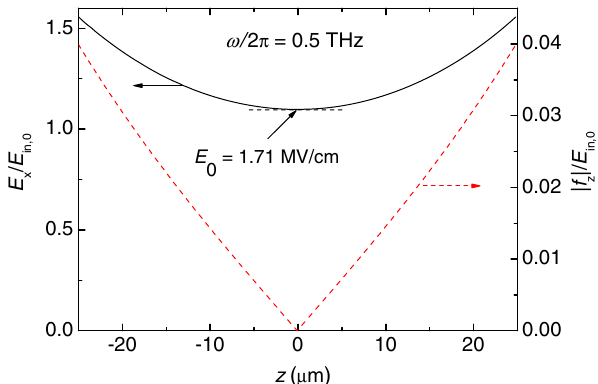
FIG. 4 . The longitudinal component of the electric field (solid line), and the absolute value of the transversal focusing/defocus- ing force acting on a unit charge (dotted line) vs the transversal coordinate. Please notice the more than one order of magnitude difference between the left and right scales.